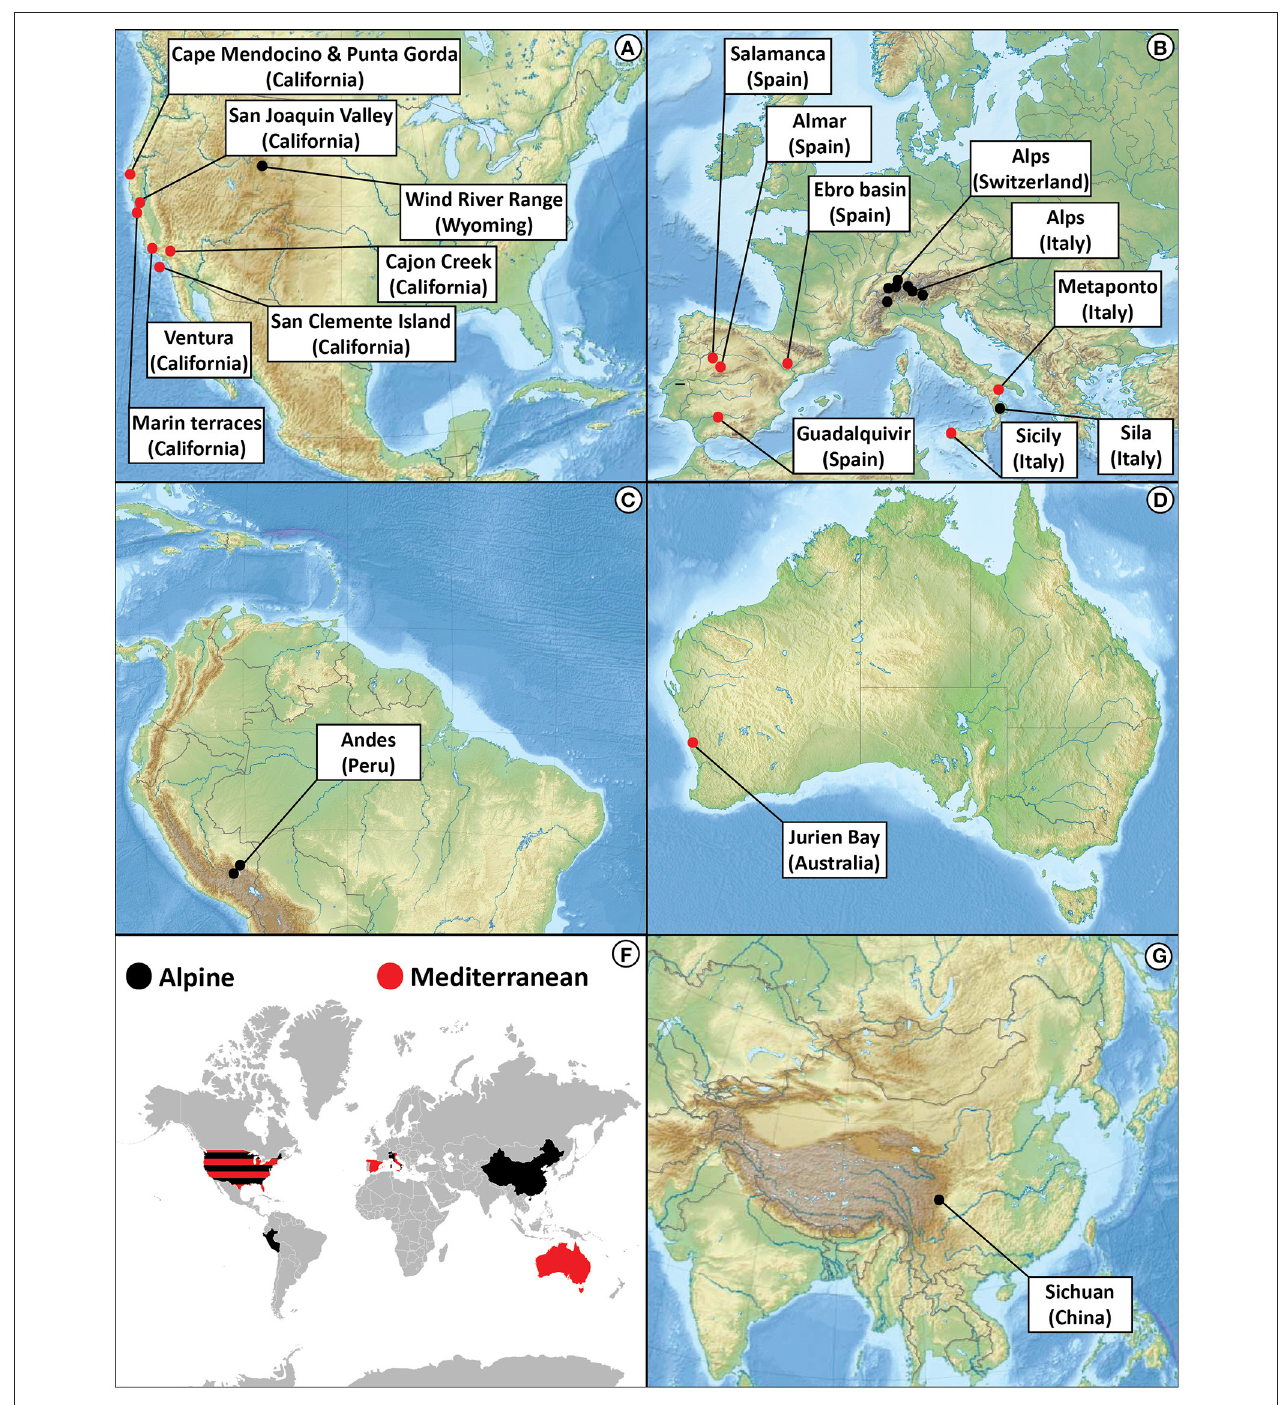
FIGURE 2 | Overview of the sites (alpine and